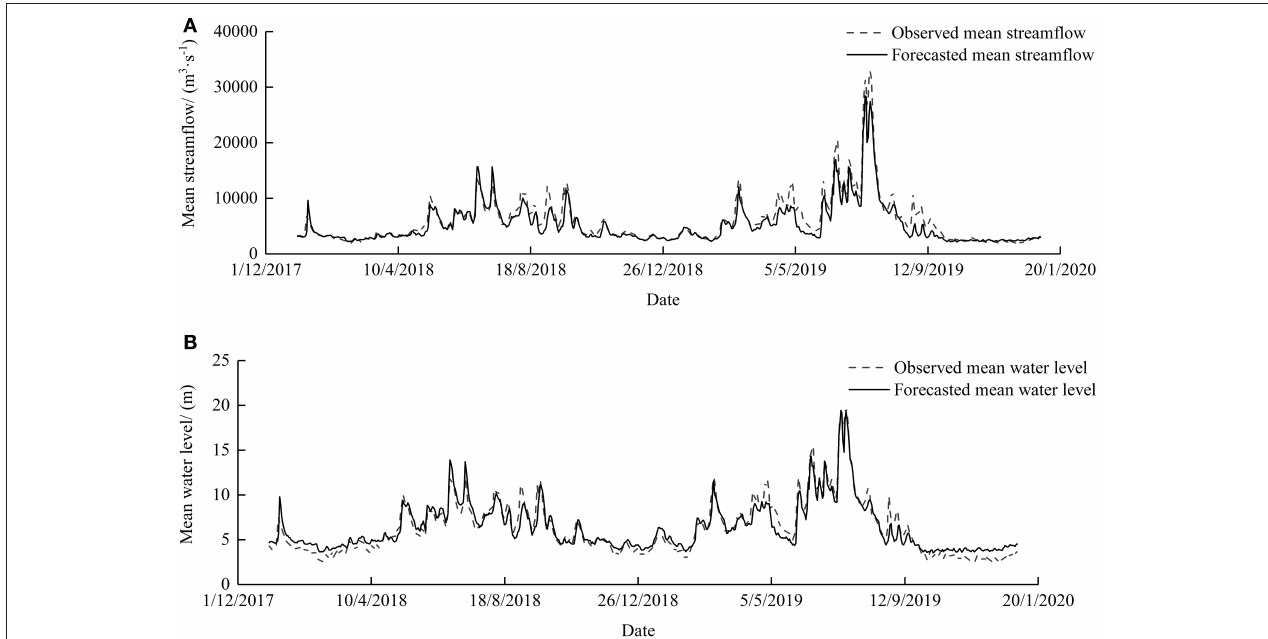
FIGURE 7 | Hydrograph of Wuxuan–Dahuangjiangkou–Wuzhou stations mean streamflow (A) and water level (B) observed and simulated by GRNN. GRNN, generalized regression neural network.